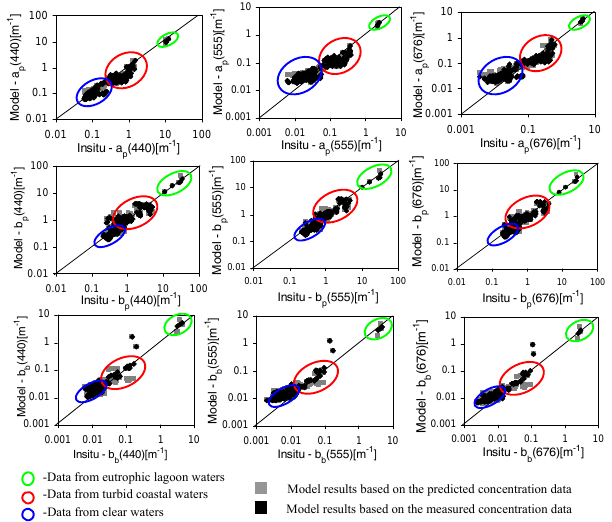
Figure 8. Comparisons of the modelled and in situ IOP data (partic- ulate absorption a p , particulate scattering b p , and backscattering b b ) at three wavelengths: 0.440, 0.555 and 0.676µm. Black colour rep- resents model results based on the in situ concentrations ([Chl( z )] and [SS( z )]) and grey colour represents model results from the pred- icated profile data (from the estimated Chl and SS concentrations using remote-sensing reflectance data).